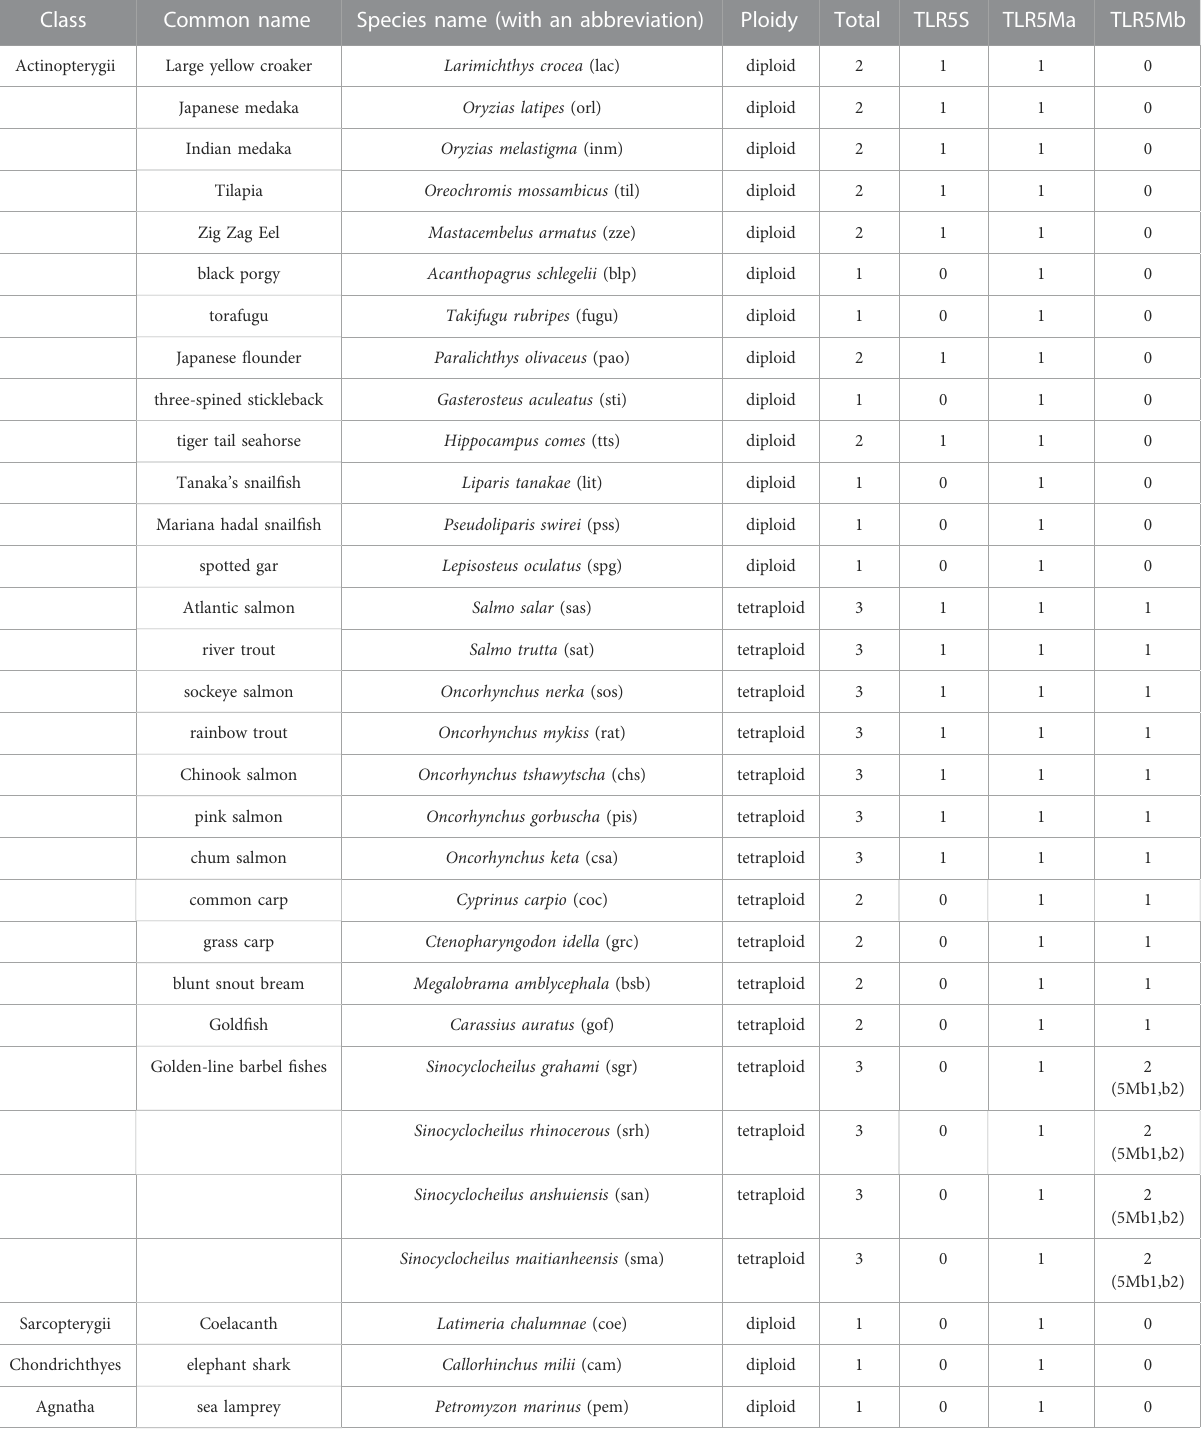
TABLE 1 Copy numbers of TLR5 genes in the examined fi sh